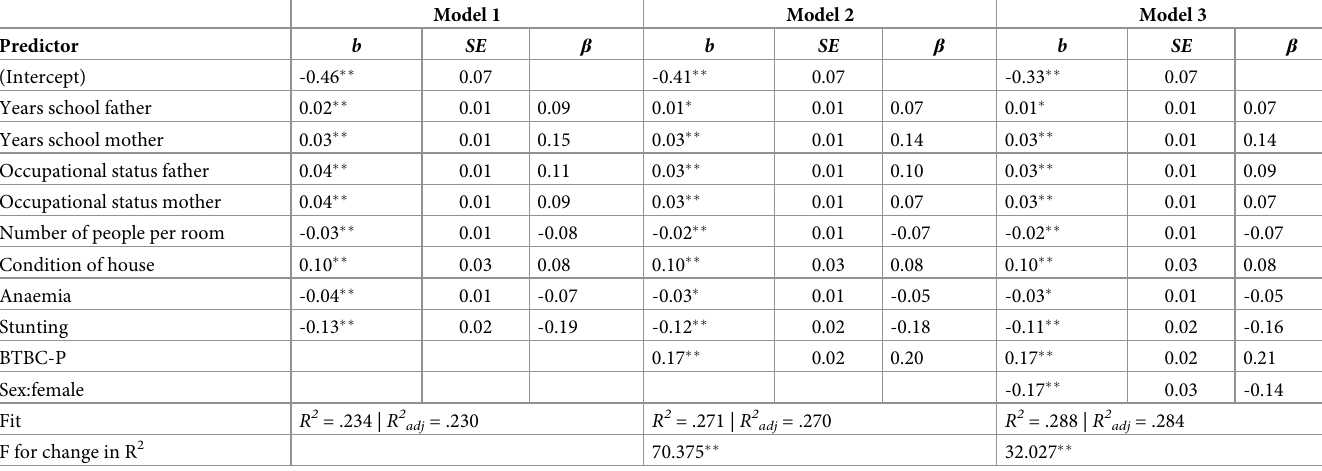
Table 4. Regression results for cognitive functioning at age 11 years predicted by early childhood risk factors (age 3 years) and cognitive functioning at age 3 years as well as